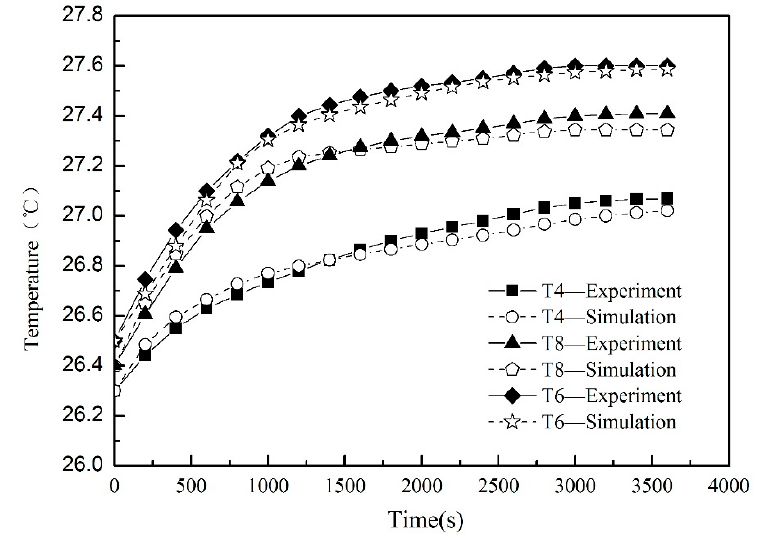
Figure 13. Comparison of simulated and experimental temperature at verified points.